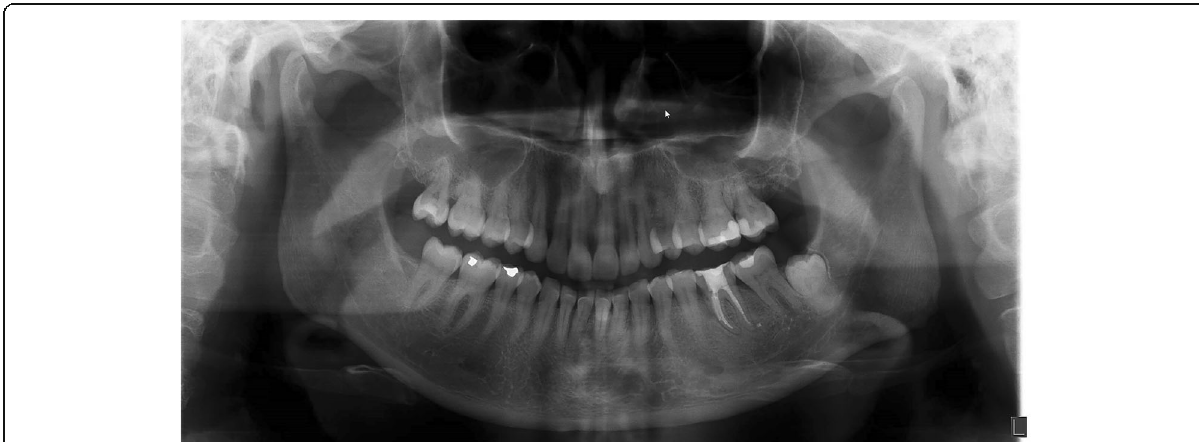
Fig. 1 Pre-operative panoramic radiograph of a failing molar in position